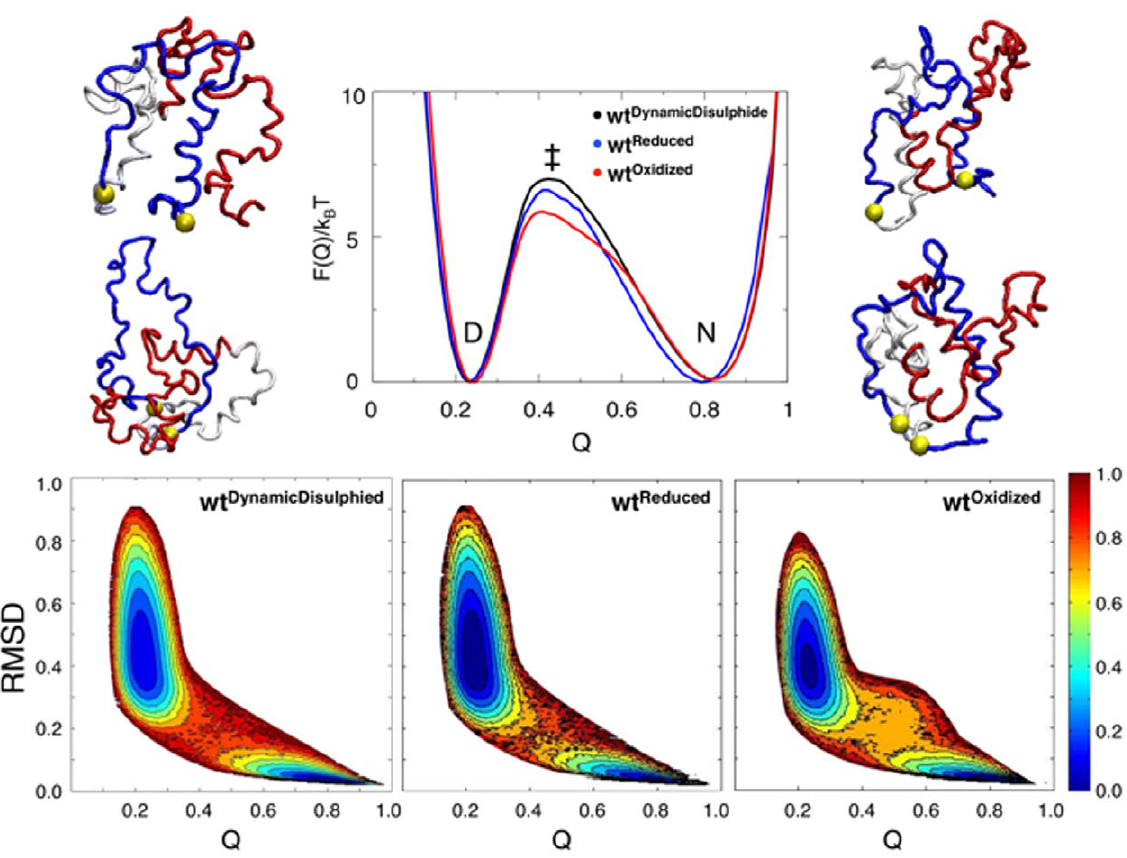
Figure 3. The free energy plot and representative structure diversity of leptin. Top panel : The free energy landscape for three folding routes of leptin, wt DynamicDisulphide (black), wt Reduced (blue) and wt Oxidized (red). It is clear from the folding trajectories that the wt DynamicDisulphide model can follow both the oxidized and the reduced routes. Therefore, four structures on the folding route are shown, two structures before the TS (Q=0.3) and two at TS (Q=0.4), on the left and right side of the free energy landscape respectively. The structures represented before the TS show that the a 2 { 3 { hairpin is structured and with the a 2 { 3 { hairpin in a native conformation while the rest of the structure is denatured. At the TS most of the protein is folded, only a 1 is unfolded. Bottom panel: The three dimensional representation of the distribution of structure diversity, measured by Q versus RMSD (F(Q, RMSD) where colors indicate normalized energy scale from top panel. The plot shows how occupied the different states are throughout the free energy landscape, from blue (low occupancy) to deep red (high occupancy). The location of the unfolded and native basins are positioned ate similar Q and RMSD with similar occupation of states indicating a similar folding route for all three models.